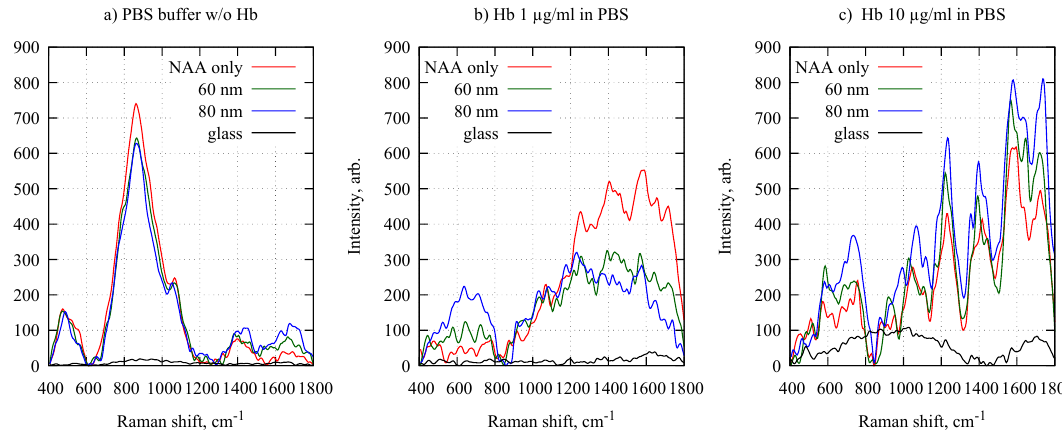
Figure 4. Typical Raman spectra of ( a ) PBS without hemoglobin and ( b , c ) different concentrations of hemoglobin diluted in PBS on a glass substrate, NAA substrate and NAA with 60 and 80 nm diameter Au